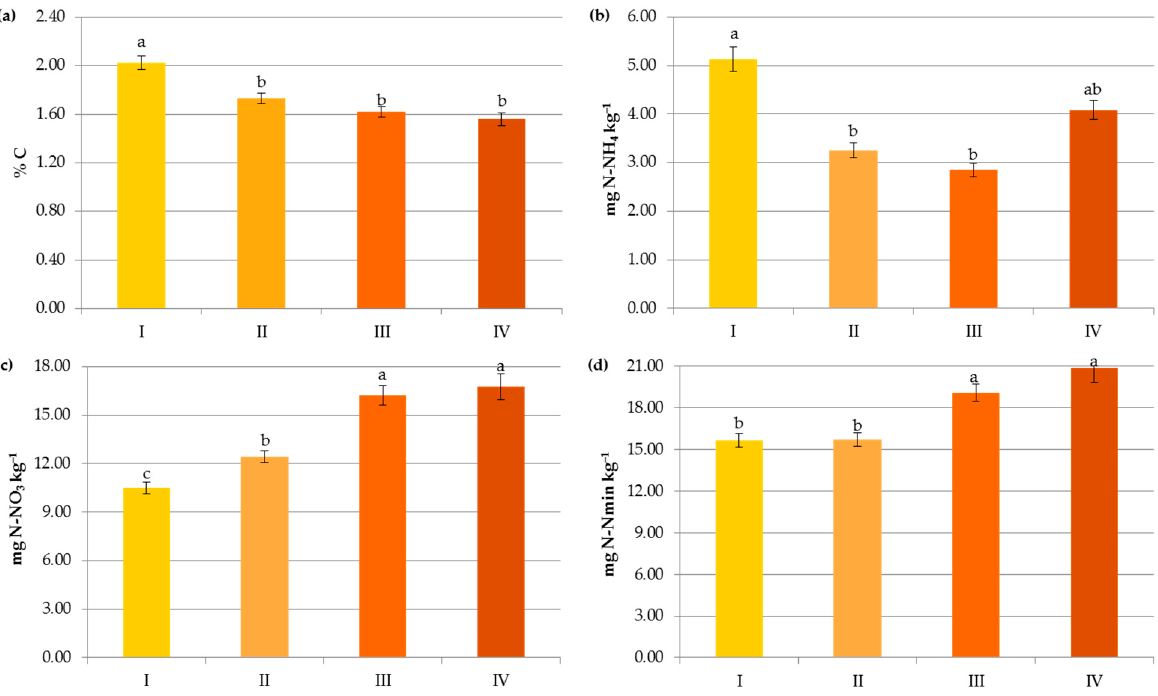
Figure 7. Impact of pre-crop N fertilization on contents of organic carbon ( a ), ammonium nitrogen ( b ), nitrate nitrogen ( c ) and mineral nitrogen ( d ): I—<50 kg N ha − 1 , II—50–100 kg N ha − 1 , III—100–150 kg N ha − 1 , IV—>150 kg N ha − 1 . The same letter means not significantly different.